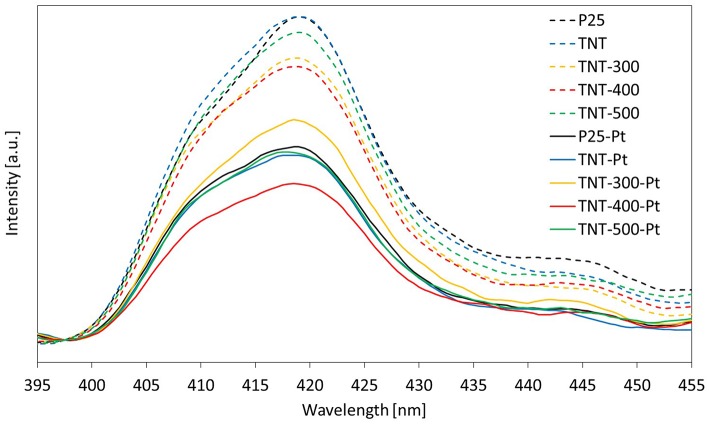
Photoluminescence spectra of different samples.